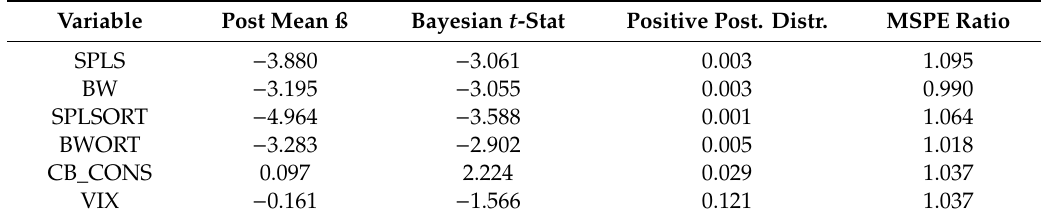
Table 3. Set of estimations run using the U.S. sentiment in order to predict the EU stock returns. Variable Post Mean ß Bayesian t